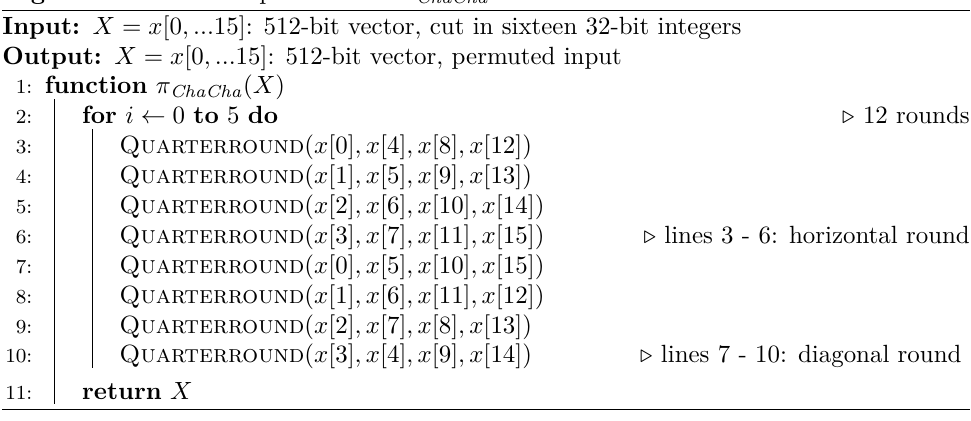
Algorithm 2 ChaCha permutation π ChaCha